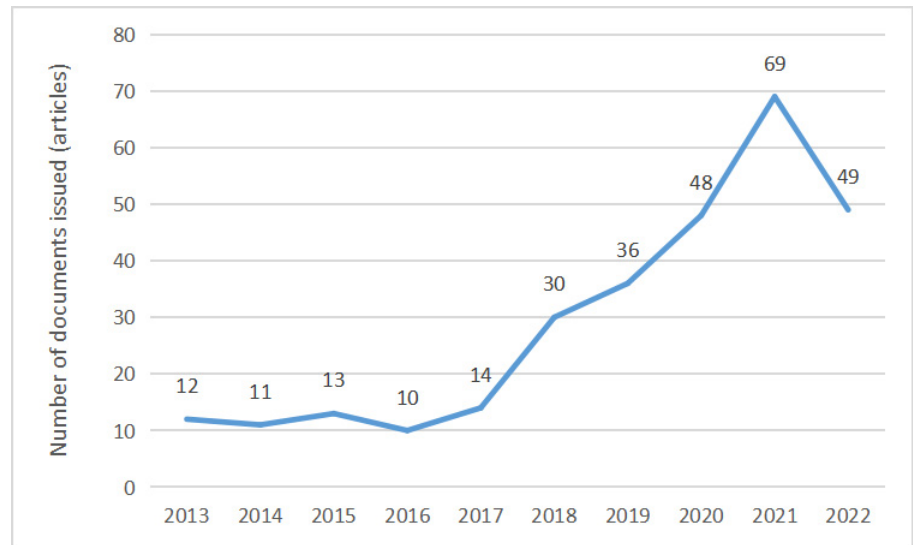
Figure 1. General trend in the literature on rural human settlement environments.